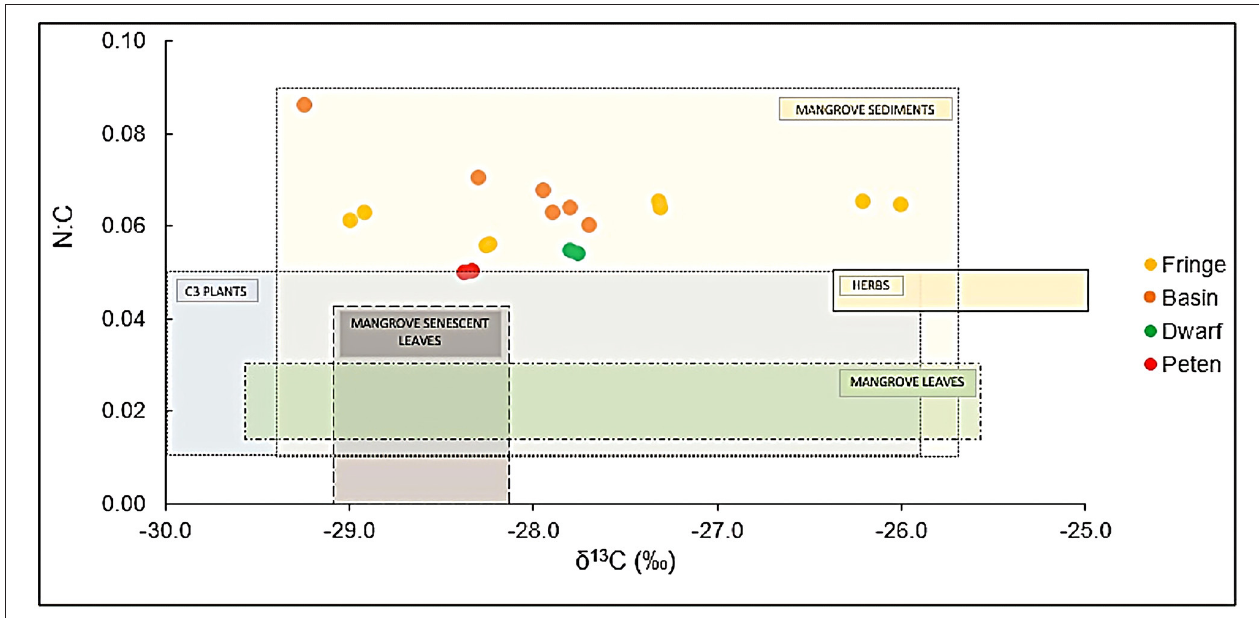
FIGURE 3 | Isotopic signals ( δ 13 C and N:C) in sediments of mangrove ecological types in Celestun. The values of possible sources of carbon and nitrogen are included: Reference data are from mangrove leaves (Wooller et al., 2003; Gonneea et al., 2004; Fry and Cormier, 2011), senescent mangrove leaves (Gonneea et al., 2004), mangrove sediments (Monacci et al., 2011), C3 plants (Adame and Fry, 2016), and mangrove associated herbs ( Batis maritima and Salicornia virginica ) (Grijalva,